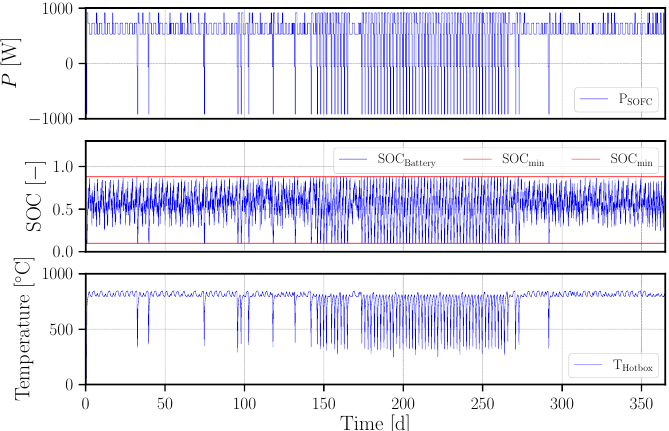
Figure 20. Exemplary annual simulation of the battery hybrid system with shutdowns of a 1 kW el SOFC power generator, a 10 kWh battery and a 15 kWh/day electricity consumption indicating the electrical load, the state of the charge of the battery (SOC) and the temperature of the hotbox.